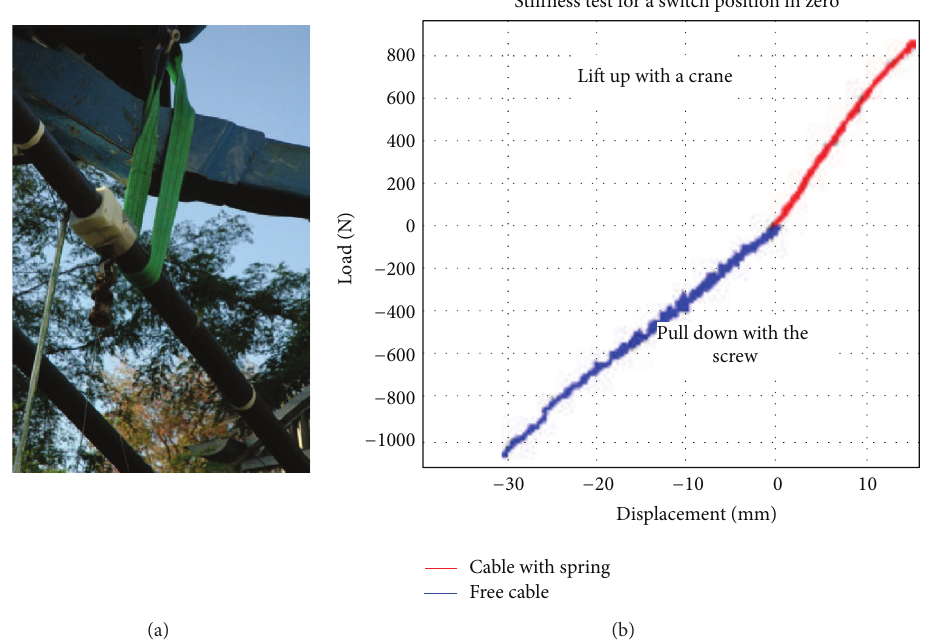
Figure 4: (a) Measurement of the static stiffness increase in cable no. 1. (b) Measured force/displacement curve.